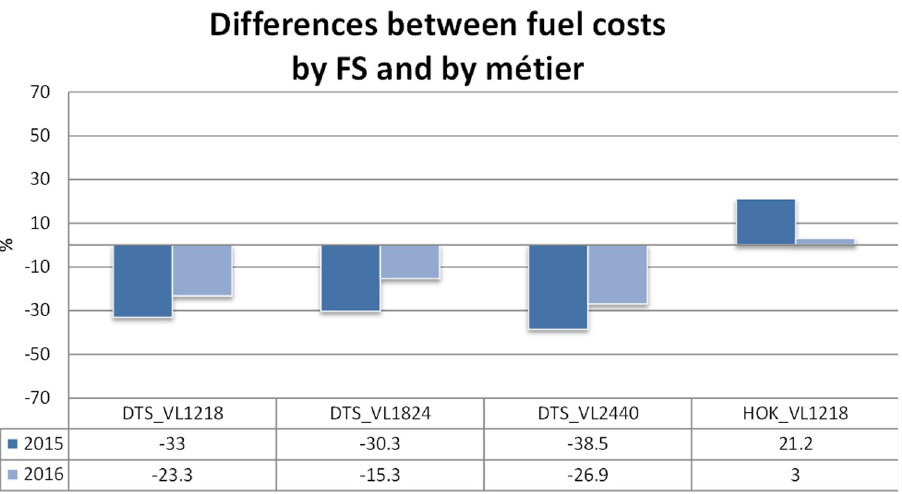
Fig 6. Differences between the fuel costs by fleet segment and by